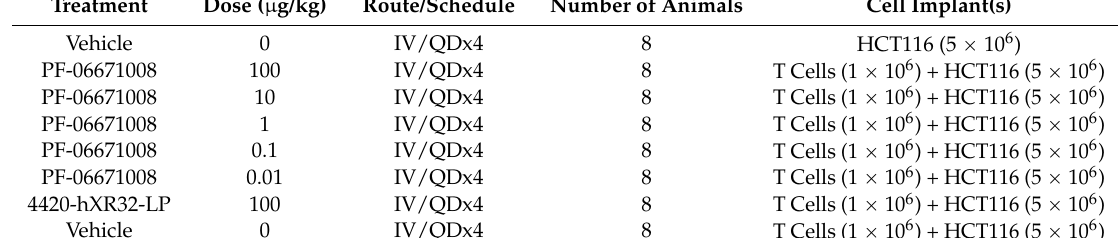
Table 7. Study Design for HCT116 Tumor Model.